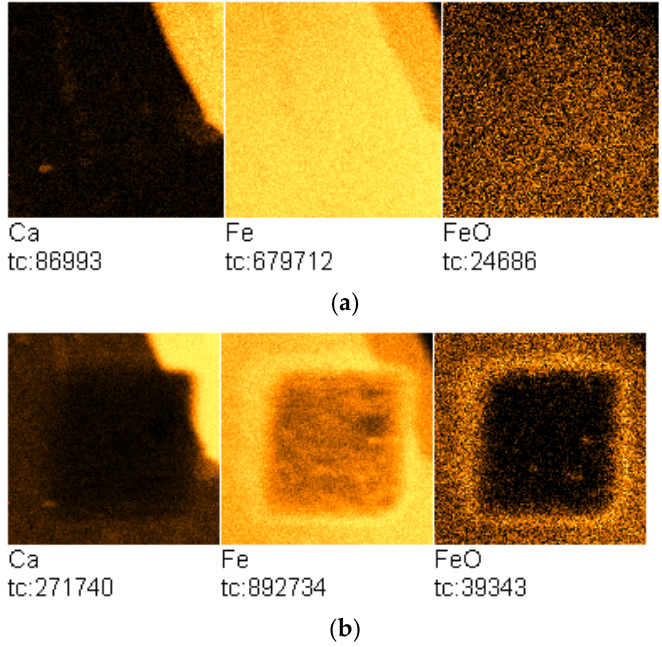
Figure 5. ( a ) TOF-SIMS image of the iron-sample surface with the visible region containing calcium oxide (field of view: 500 × 500 μ m 2 ; sample Fe/Ca(OH) 2 ); ( b ) TOF-SIMS image of the sample surface area analyzed with temperature-programmed TOF-SIMS (field of view: 500 × 500 μ m 2 ; sample Fe/Ca-T). Total counts (tc) for particular ions are presented below each image.